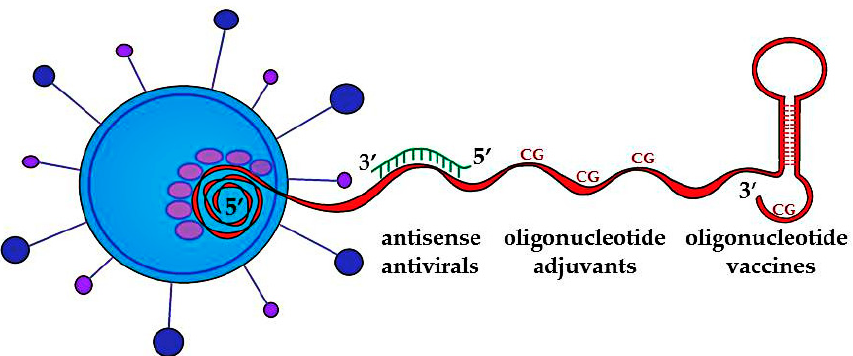
Figure 1. Genetic material of SARS coronaviruses as a source for creation of antisense antivirals, oligonucleotide adjuvants, and oligonucleotide vaccines.